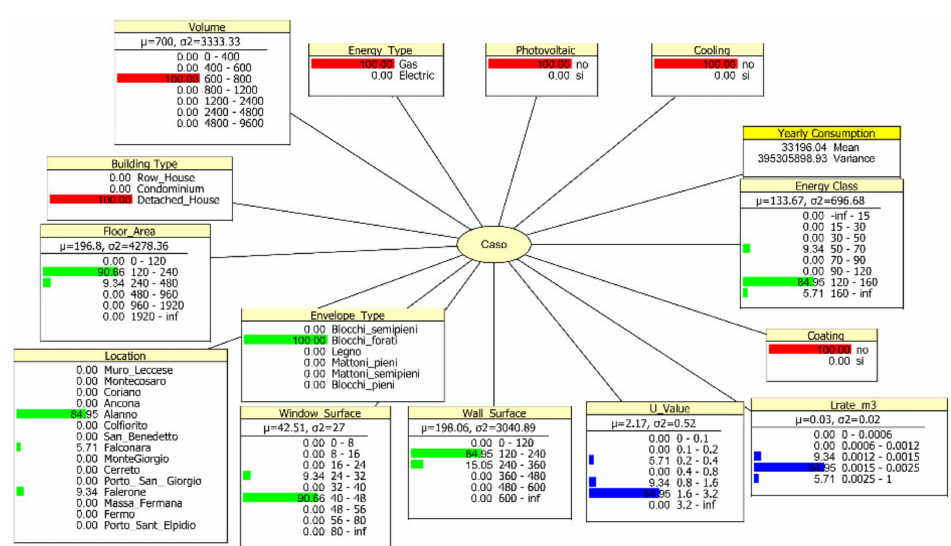
Figure 15. A new example showing uncertainty management.